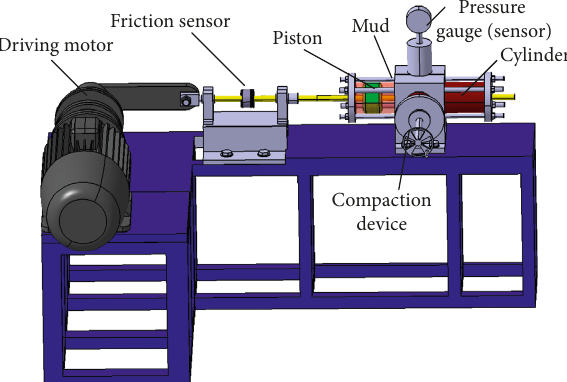
Figure 3: Mud pump piston seal test